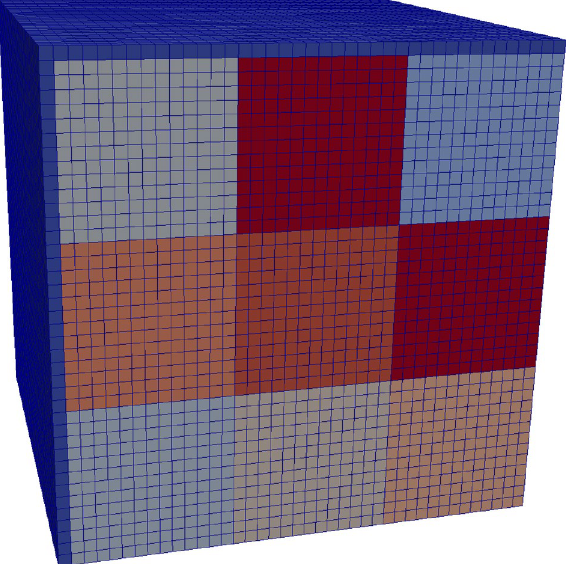
Figure 5. Simplified geometry of the SMC material consisting of 3 × 3 × 3 magnetic grains separated with one non-magnetic interparticle layer (dark blue). The size of each grain is 300 nm × 300 nm × 300 nm , whereas the interparticle thickness is varied.